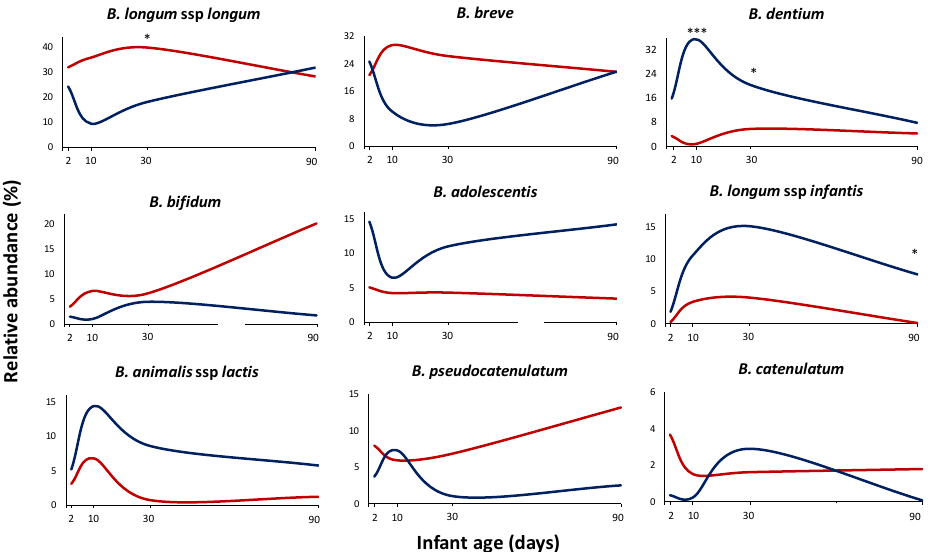
Figure 2. Bifidobacterial relative abundance. Average relative proportions of the dominant (sub)species during the first three months of life in the control group (red line) and antibiotic group (blue line). * Indicates statistically significant differences (* p < 0.05; *** p < 0.001) at the corresponding sampling times (2, 10, 30, or 90 days of age).